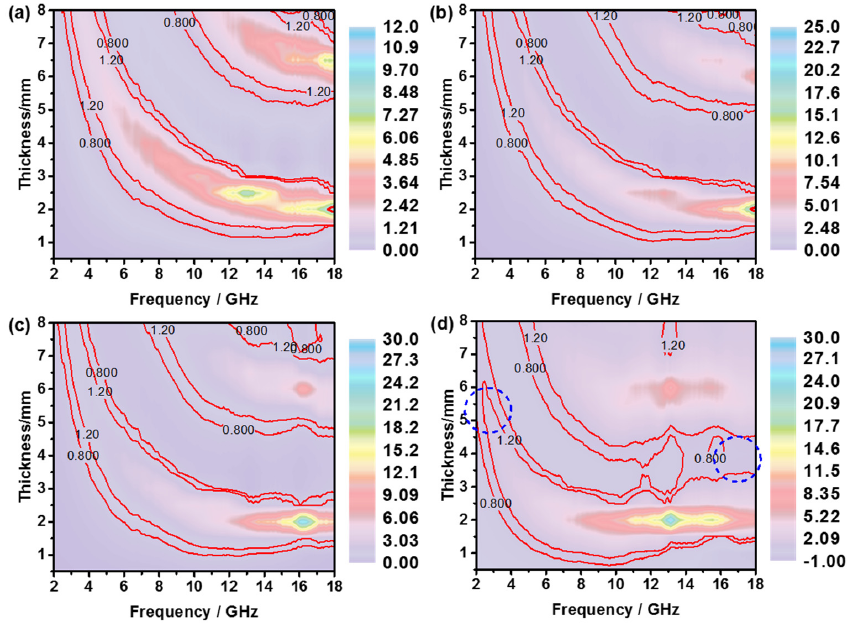
Figure 9. 2D diagram of impedance matching distribution in C1 ( a ), C2 ( b ), C3 ( c ) and C4 ( d ).